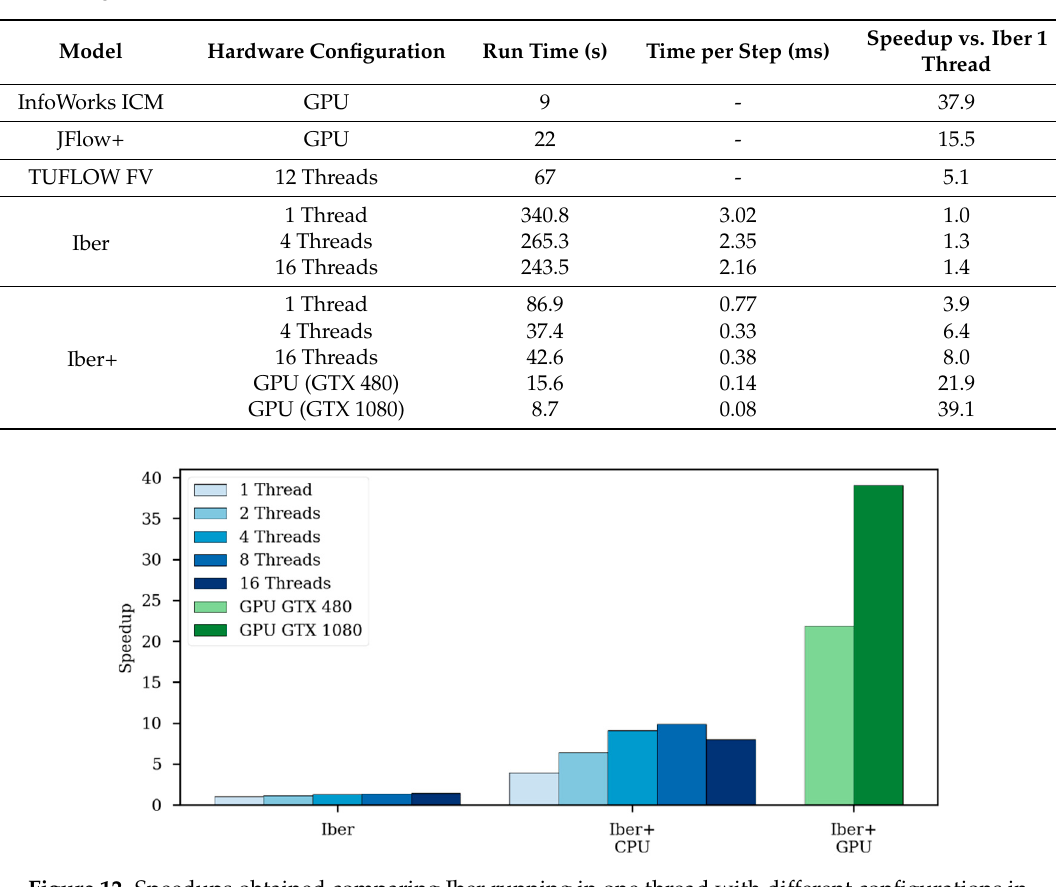
Figure 12. Speedups obtained comparing Iber running in one thread with different configurations in Test 5.